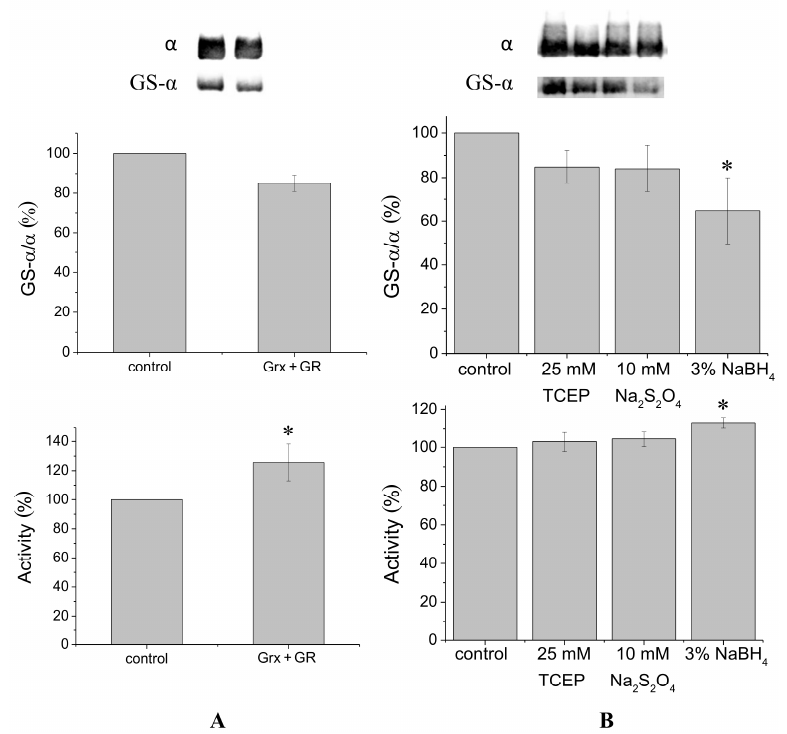
Figure 1. Deglutathionylation of the Na,K-ATPase α 1-subunit in the absence of denaturing reagents. ( A ) Deglutathionylation using the coupled enzyme system glutaredoxin (20.6 µ g/mL) and glutathione reductase in the presence of 0.5 mM glutathione and 200 µ M nicotinamide adenine dinucleotide phosphate (NADPH). Samples were incubated for 30 min at 37 ◦ C. Control samples (taken as 100%) were incubated under the same conditions without reduced glutathione and the enzymes. The upper panel presents results of immunoblotting with staining by antibodies against bound glutathione and against Na,K-ATPase α 1-subunit. The lower panel shows change in enzyme activity (number of experiments: N = 3); ( B ) Deglutathionylation using chemical reducing agents: 25 mM tris(2-carboxyethyl)-phosphine (TCEP), 10 mM Na 2 S 2 O 4 , and 3% NaBH 4 . The incubation time was 30 min at 37 ◦ C. The upper panel depicts immunoblotting with staining by antibodies against bound glutathione and against the α 1-subunit. The results were normalized to the α 1-subunit content. Lower panel: change in Na,K-ATPase activity after treatment by reducing agents ( N = 4). Data are presented as mean ± standard deviation (SD) of independent experiments. * p < 0.05.